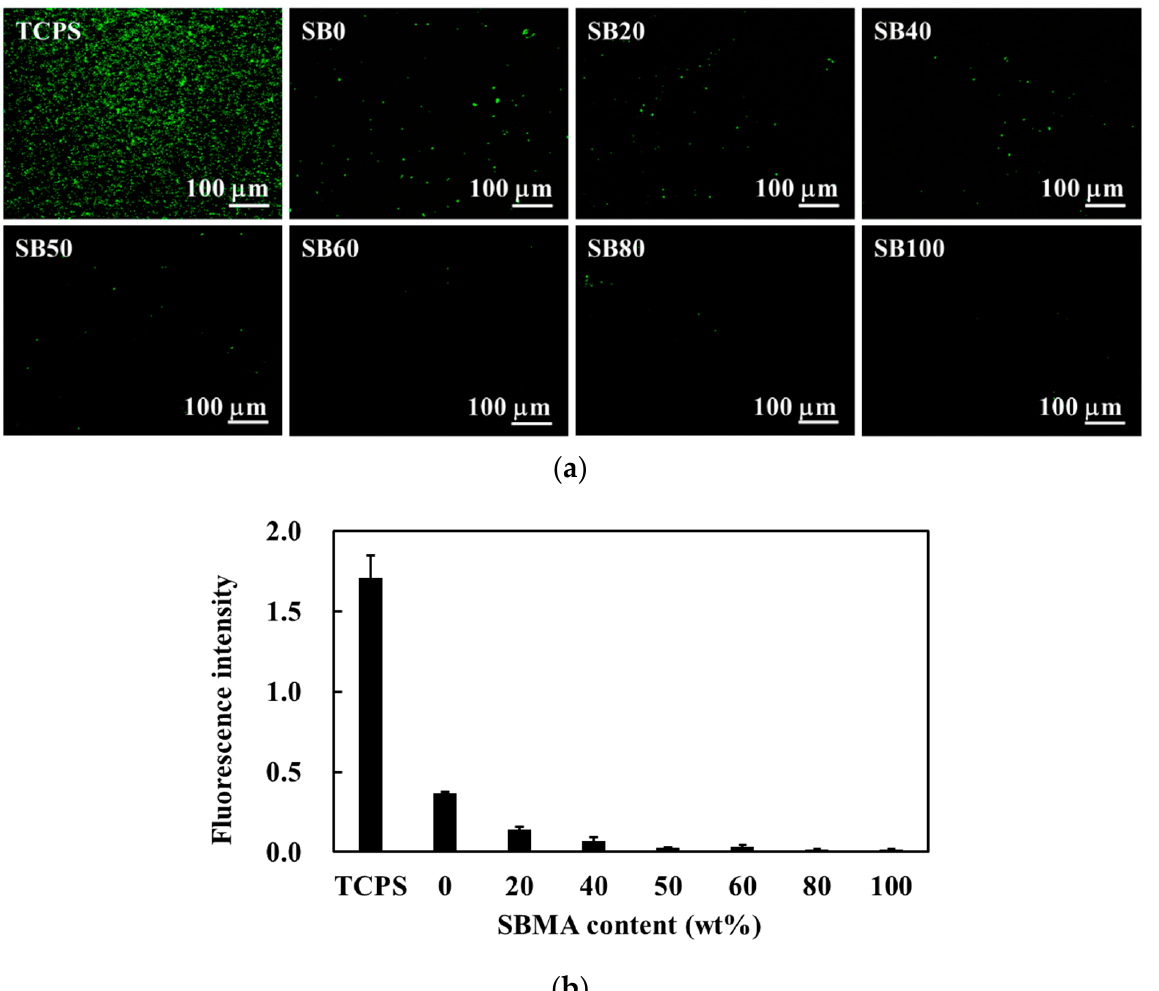
Figure 3. ( a ) Fluorescence images of S. aureus attachment to the hybrid HEMA/SBMA hydrogels. ( b ) The fluorescence intensity was analyzed using Image J. Value = mean ± standard deviation, n = 5.